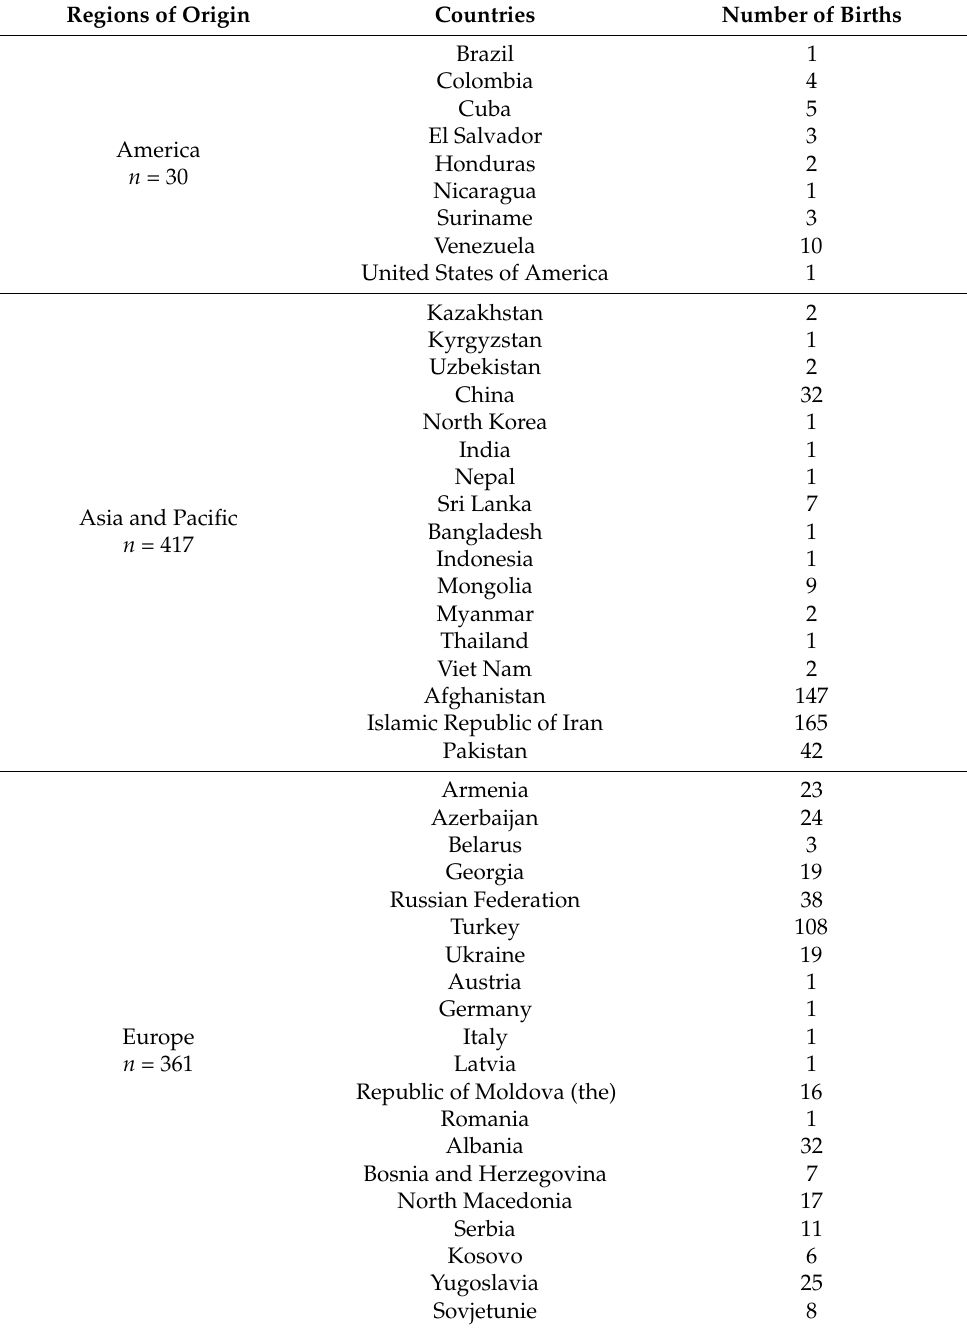
Table A2. Number of births per country of